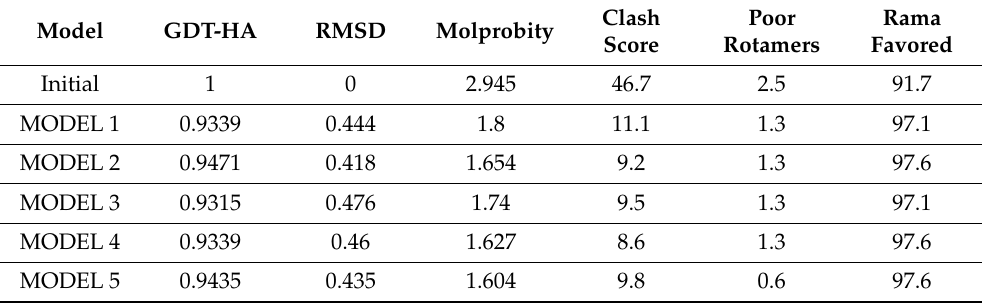
Table 3. Structural features of the five models generated after refining the multi-epitope vaccine